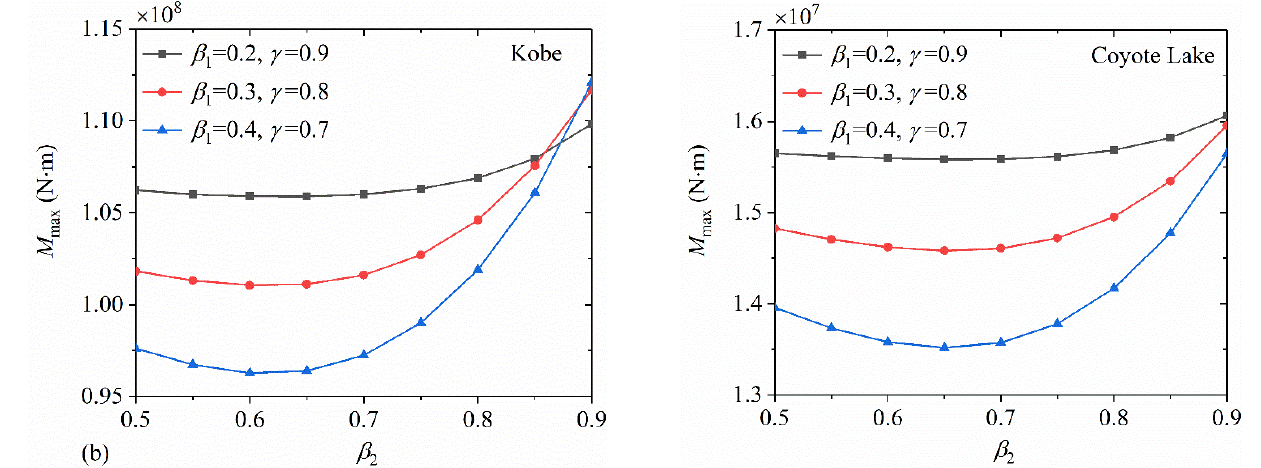
β : ( a ) the β 2 : ( a ) the 2